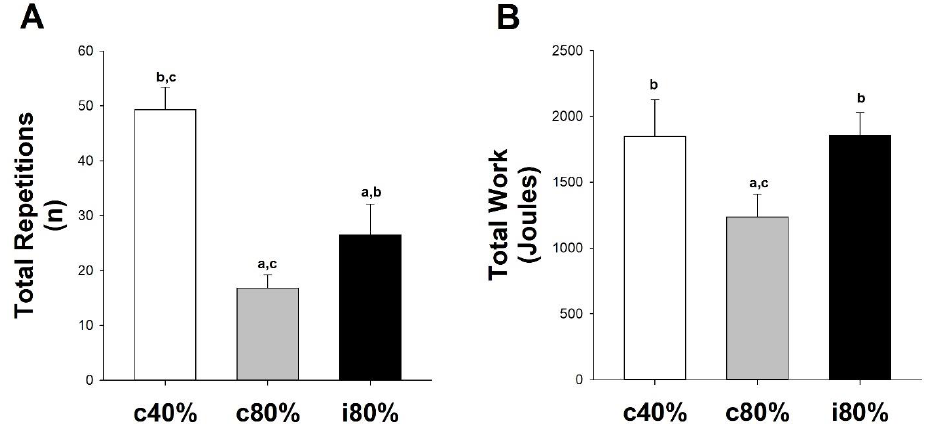
Figure 4. Impact of Interrepetition Rest on Exercise Tolerance to Heavy Weight Single-Leg Knee Extension Resistance Exercise. ( A ) Total repetitions performed and ( B ) total work during knee extension performed continuously at 40% (c40%) and 80% (c80%) of one-repetition max (1RM), as well as intermittently with 2 s of interrepetition rest at 80% (i80%) 1RM. a: significantly different than the c40% trial; b: significantly different than the c80% trial; c: significantly different than the i80% trial.